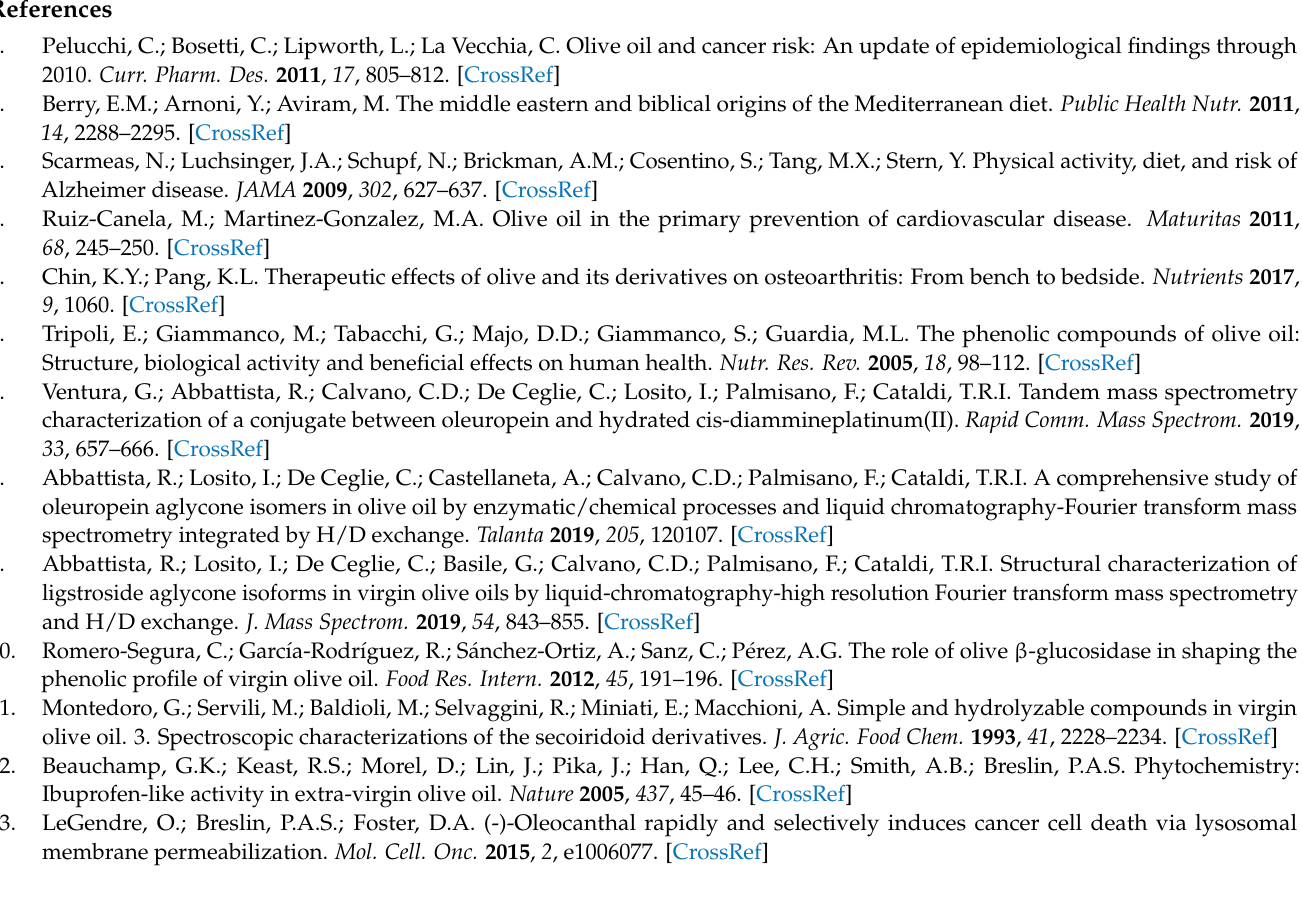
Figure S5: Extracted Ion Current (XIC) chromatograms referred to monoisotopic deprotonated standard oleocanthal and oleacin. Figure S6: Extracted Ion Current (XIC) chromatograms referred